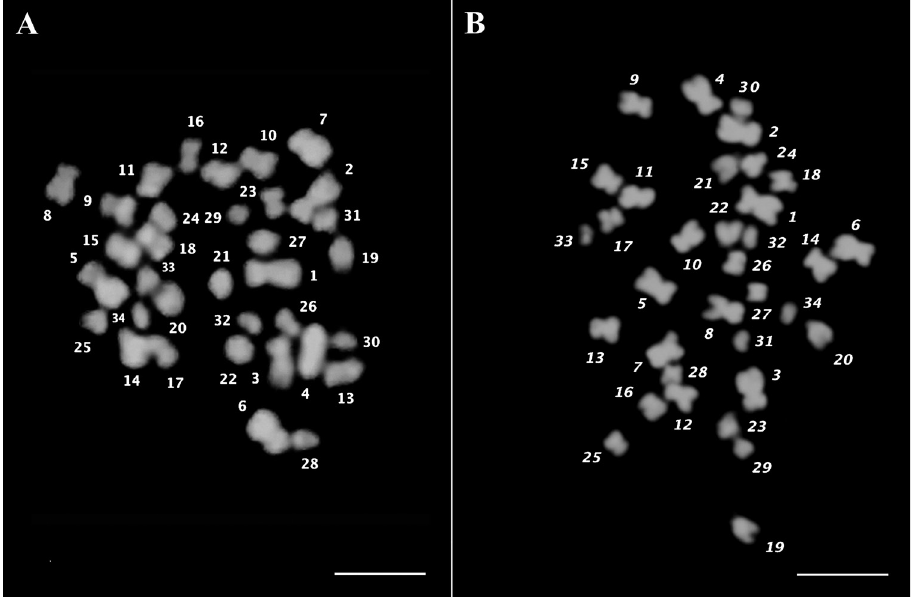
Figure 3. Chromosome numbering. Metaphase spreads showing numbered chromosomes of cardoon ( A ) and globe artichoke ( B ) counterstained with DAPI. Scales bars: 5